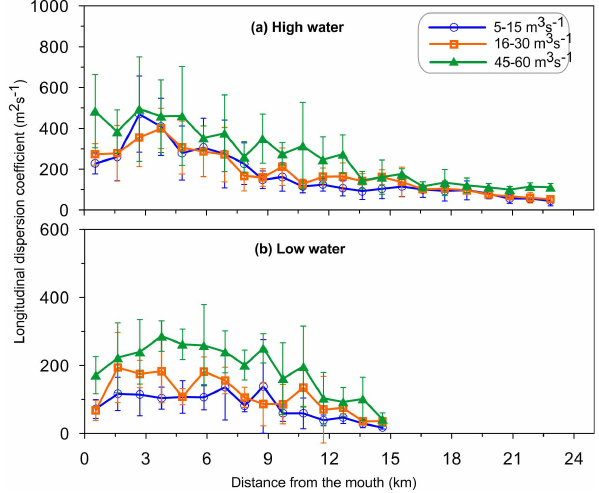
(Fig. 4b). The mean value of D i (x) is around 79 m 2 s − 1